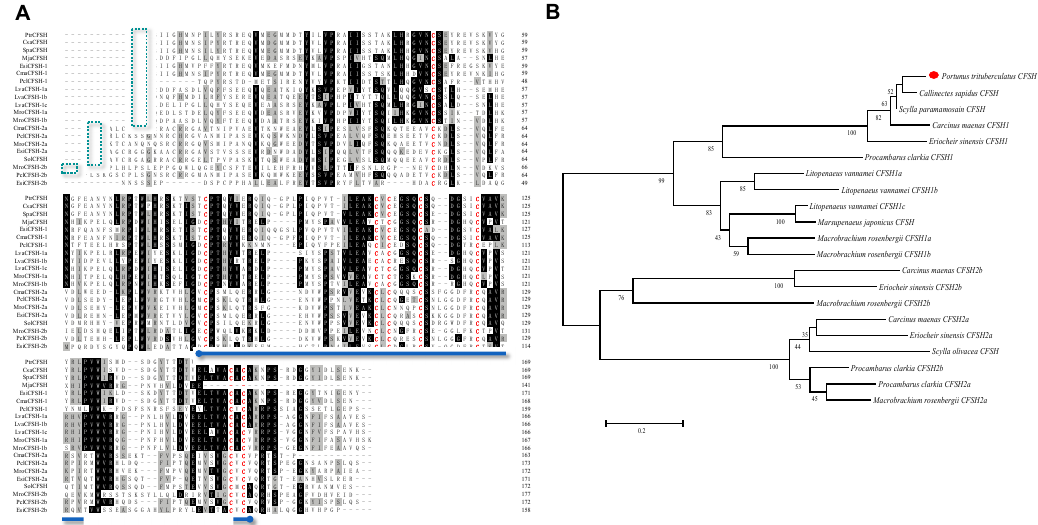
Figure 2. Multiple sequence alignment and phylogenetic tree of the CFSH mature peptide in decapoda. ( A ) Multiple amino acid sequence alignment of insulin family peptides. Most of the CFSH sequences were borrowed from previous works by [21]; other sequences were shown in Table 2. Cleavage site “KR” is marked with a green box. The eight cysteines are marked in red and the interleukin-17 domain is marked with a blue underline. ( B ) Phylogenetic tree of CFSHs in crustaceans. Phylogenetic analysis was conducted by the neighbor-joining method in MEGA7. The percentage of replicate trees in which the associated taxa clustered together in the bootstrap test (1000 replicates) was shown next to the branches. PtCFSH was indicated by a red dot.